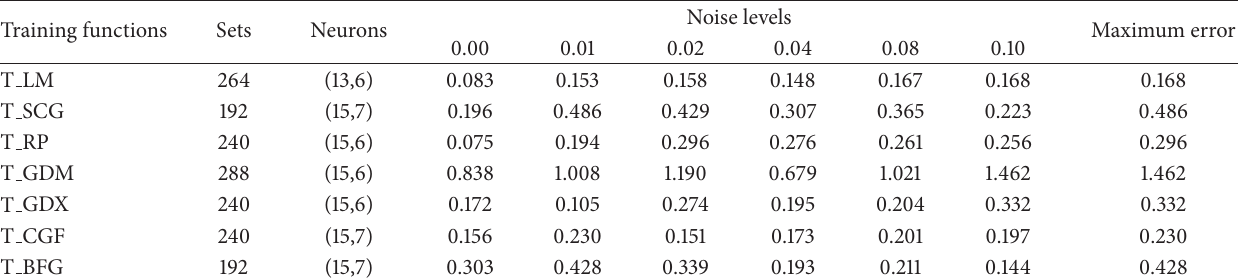
Table 17: The choice of the best neural network based on the acceleration damage parameters. Training